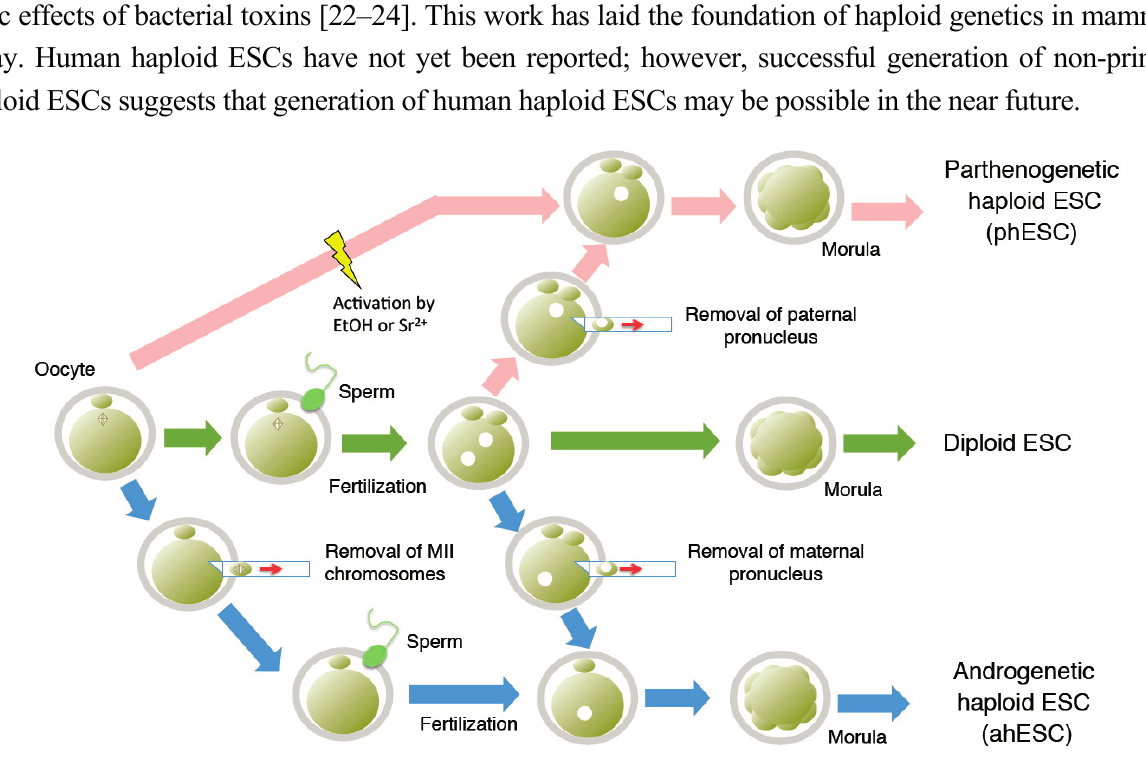
Figure 2. Generation of haploid ESCs via a range of methods. Pink arrows: generation of phESC; blue arrows: generation of ahESC; green arrows: generation of normal diploid ESC; yellow shape: artificial activation by ethanol (EtOH) or strontium chloride (Sr 2+